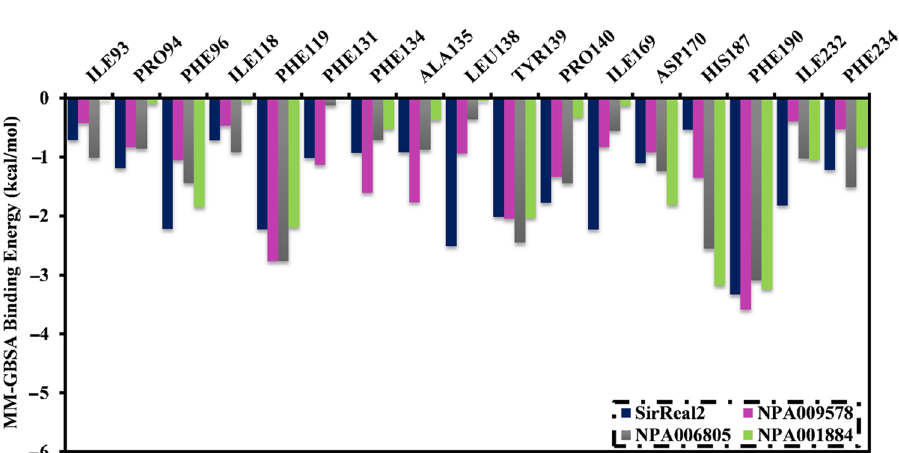
Figure 6. Energy contributions of the essential amino acids to the total MM-GBSA binding energy (kcal/mol) of SirReal2, NPA009578, NPA006805, and NPA001884 in complex with SIRT2